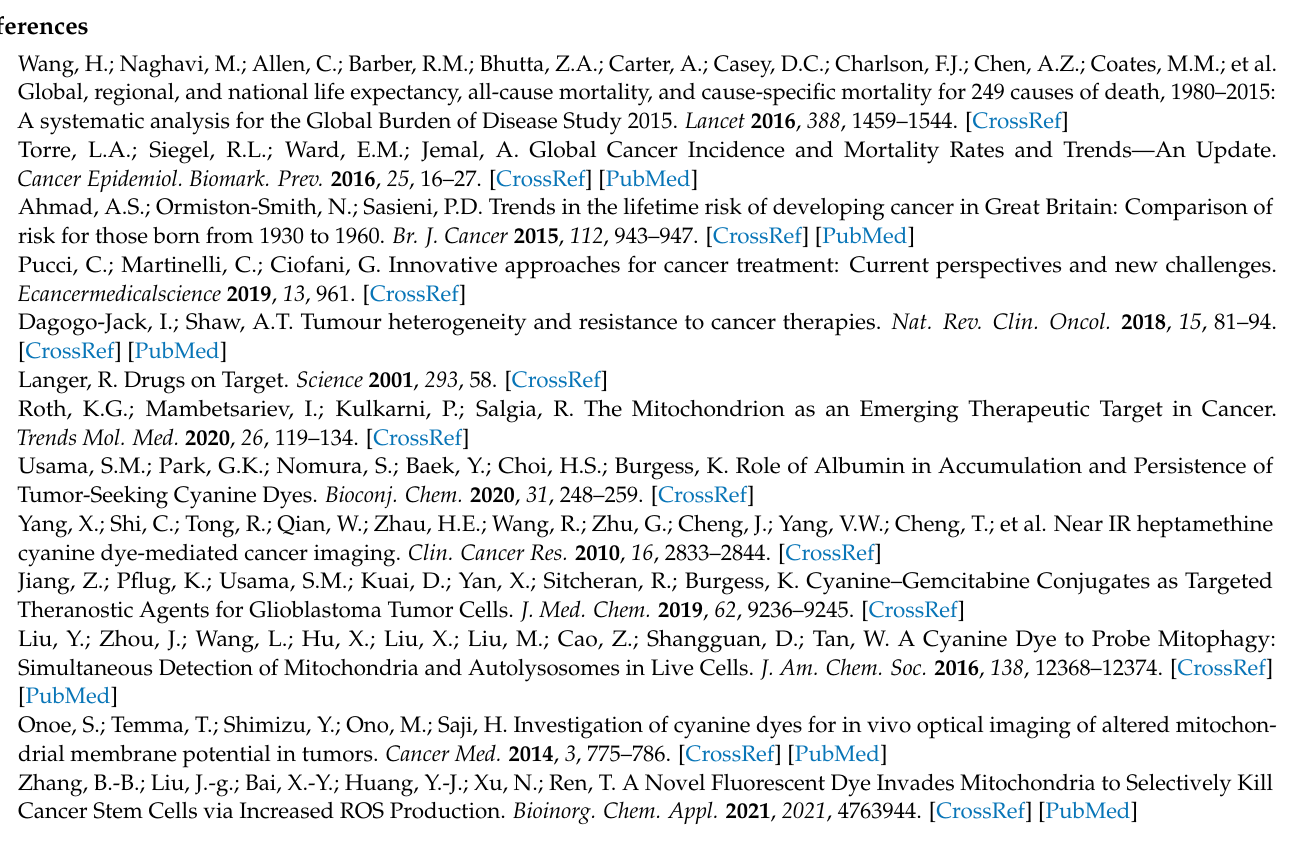
plots of Cy3-containing conjugate uptakes by SK-OV-3 and MCF7 cells, Figure S9: TIC chromatogram of compound 2 , Figure S10: TIC chromatogram of compound 3 , Figure S11: TIC chromatogram of compound 4 , Figure S12: TIC chromatogram of compound 5 , Figure S13: TIC chromatogram of compound 6 , Figure S14: TIC chromatogram of compound 7 , Figure S15: TIC chromatogram of compound 8 , Figure S16: TIC chromatogram of compound 9 , Figure S17: TIC chromatogram of compound 10 , Figure S18: TIC chromatogram of compound 11 , Figure S19: TIC chromatogram of compound 12 , Figure S20: TIC chromatogram of compound 13 , Figure S21: Cytotoxicity of compounds 1 – 13 towards KB cells, Figure S22: Cytotoxicity of compounds 1 – 13 towards MCF7 cells, Figure S23: Cytotoxicity of compounds 1 – 13 towards HEK293 cells, Figure S24: Cytotoxicity of compounds 1 – 13 towards SK-OV-3 cells, Table S1: Calculated and found mass to charge ratio for compounds 1 – 13 by mass spectroscopy. Reference [45] are cited in supplementary